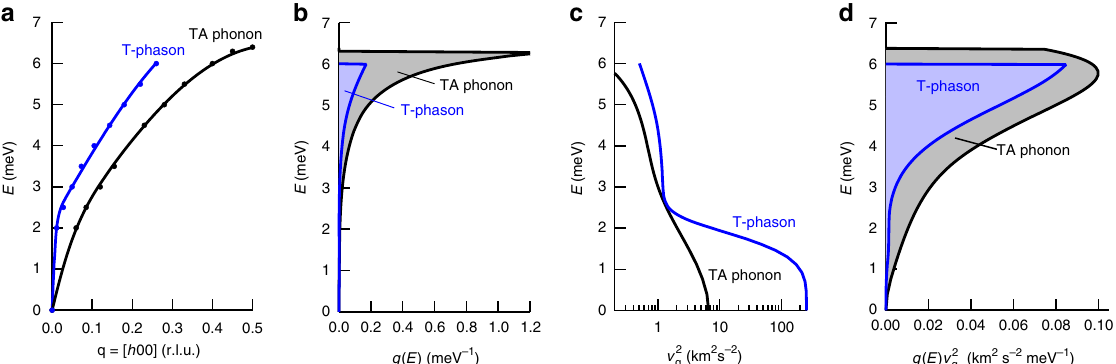
Fig. 5 Phason and phonon thermal conductivity from dispersion. a Analytic curves fi t to the dispersion data. Both data sets were fi t using the function E ( q ) = A sin α q þ B tanh β q , where the fi t constants are A = 5 meV (5 meV), α = 2.8 r.l.u. − 1 (3.38 r.l.u. − 1 ), B = 1.447 meV (2.166 meV), and β = 17.27 r.l.u. − 1 (103.9 r.l.u. − 1 ) for the TA phonon (T-phason). b Mode densities of states, g ( E ), for the TA phonon normalized to 1 and the T-phason normalized to 0.16 (estimated from incommensurate superstructure, see text). The mode partial densities of states scale as g ð E Þ / q 2 ð E Þð d q = d E Þ . c Square of the mode group ¼ d E = d q ð Þ 2 . d Density of states weighted squared group velocities. Assuming similar mode lifetimes the blue area relative to the gray area in d velocities v 2 g estimates a T-phason contribution that is about 50% of the TA phonon contribution